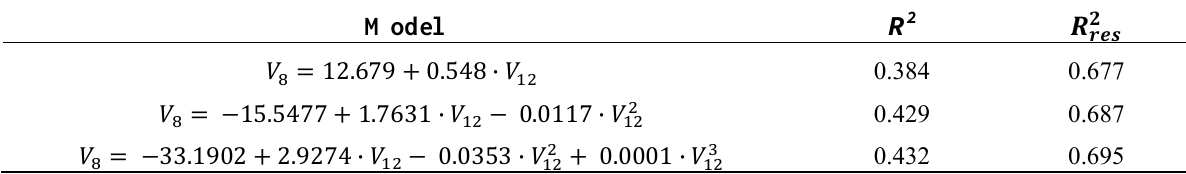
Table 3. Regression analysis between vegetation indices V-8 and V-12.